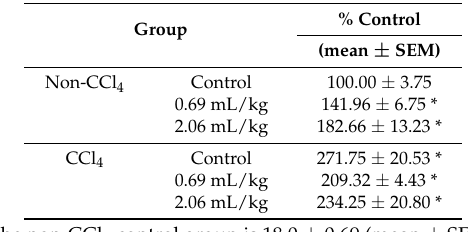
Table 5. Effects of SOD-Like Supreme treatment on plasma SDH activity in mice with/without CCl 4 challenge.